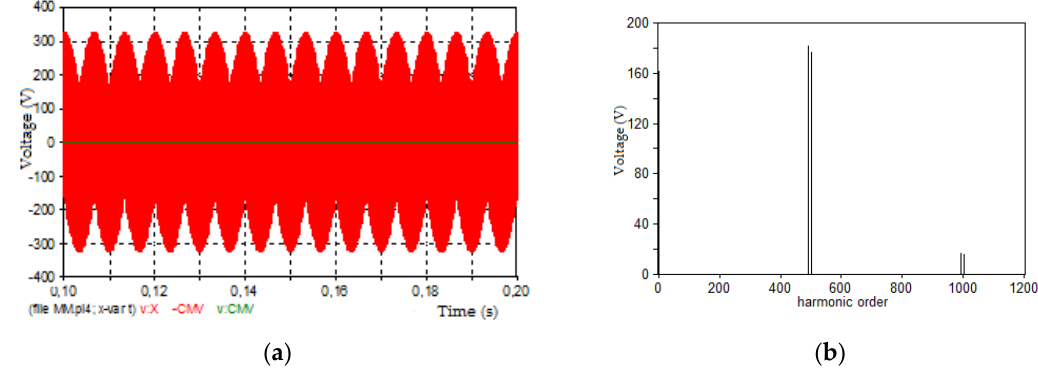
Figure 8. Waveforms of the output voltage (red lines) and CMV (green line) ( a ) and Fourier analysis ( b ) of the output voltage, synthesized in conventional MC by the use of CCW rotating space vectors, for the output frequency of 50 Hz.